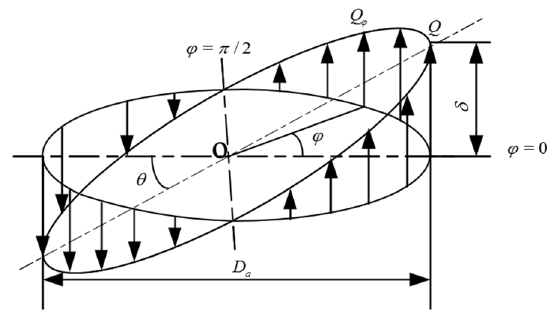
Figure 4. Load distribution under torque load.